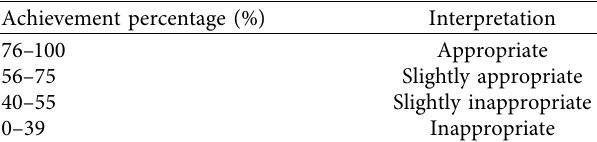
Table 2: Percentage